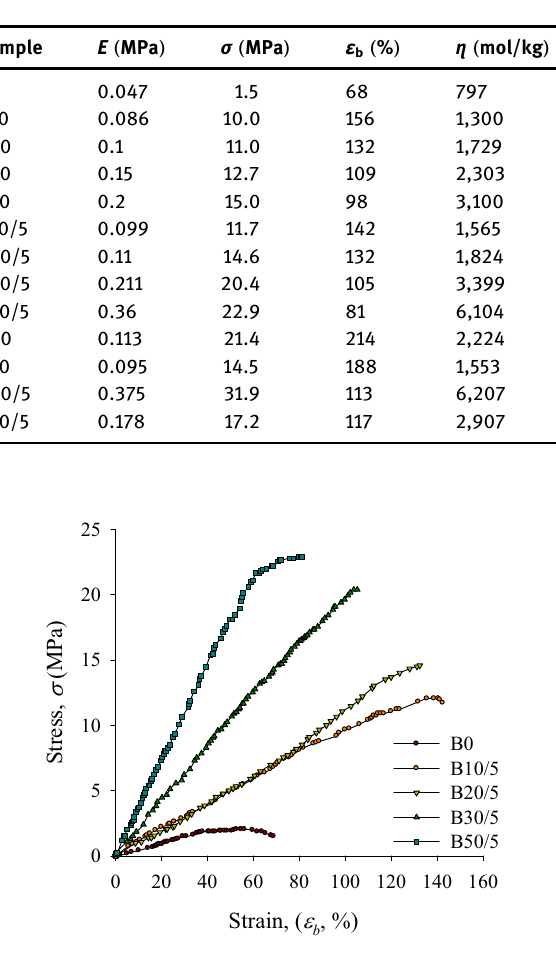
Table 3: Mechanical properties of un fi lled and fi lled